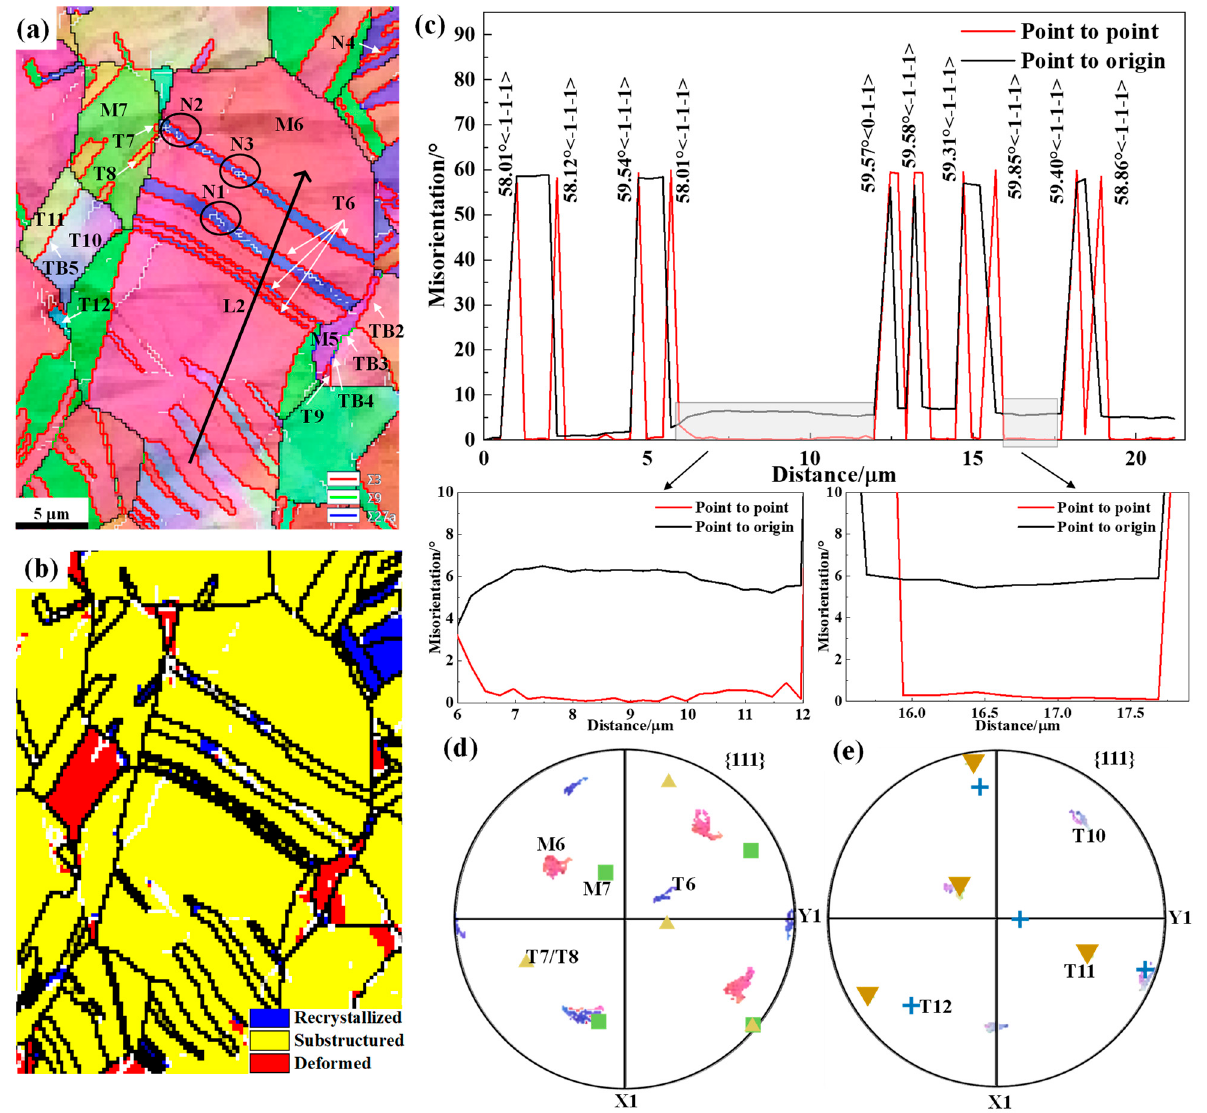
Figure 9. The specific macrozones III in Figure 7a: ( a ) IPF map; ( b ) recrystallization map; ( c ) misori- entation analysis along line L2 in Figure 9a; ( d ) and ( e ) {111} pole figure of specific grains.